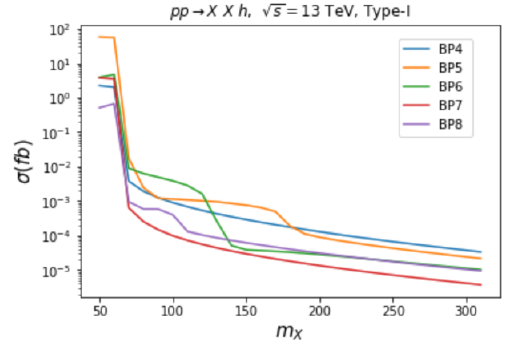
Figure 10 . Cross sections as a function of m (cid:31) for mono-Higgs production via the (cid:31)(cid:31)h (cid:12)nal state. The benchmark points are presented in tables 2 and 3.